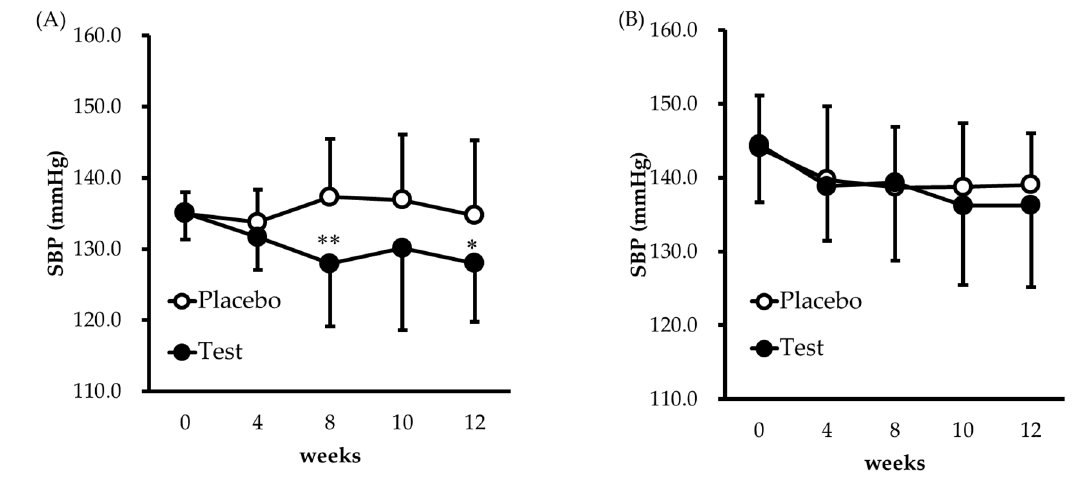
Figure 4. Changes in SBP over 12 weeks in participants who received the test food or the placebo ( A ): high-normal BP; ( B ): grade 1 hypertension. * p < 0.05, ** p < 0.01, significantly different from the placebo group. Each value is expressed as the mean ± SD.